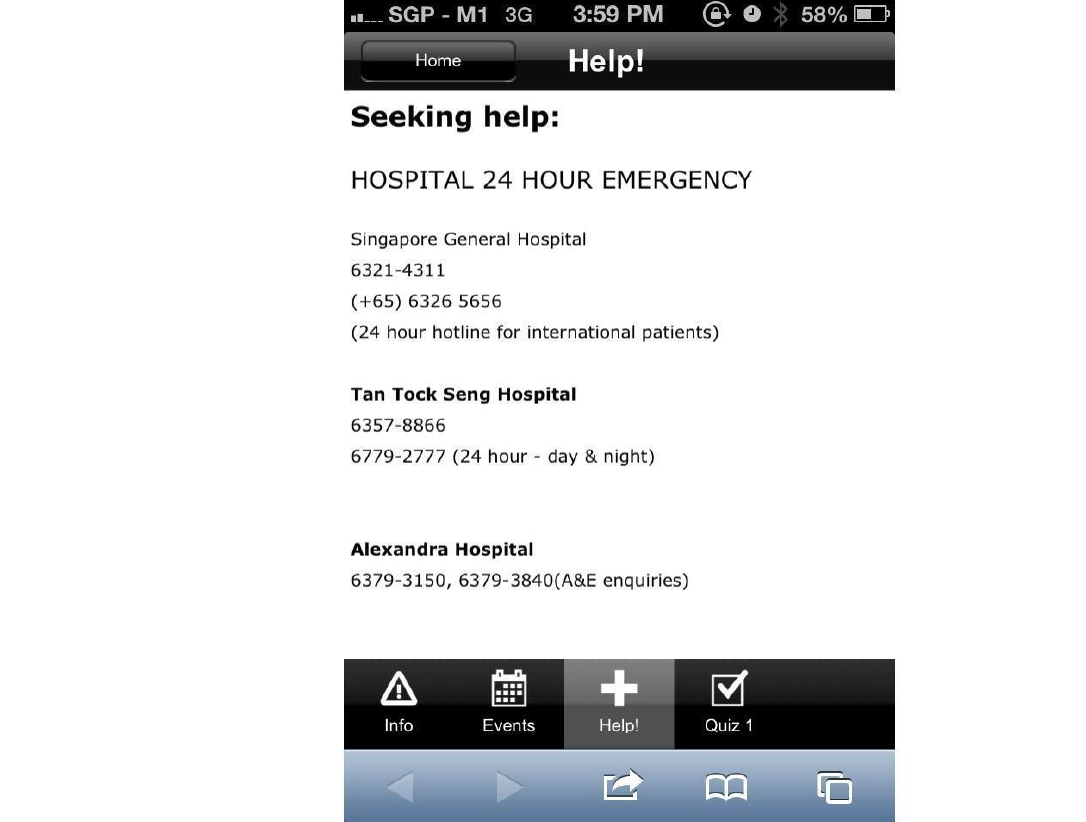
Figure 4. Emergency department and clinic contact details within application.